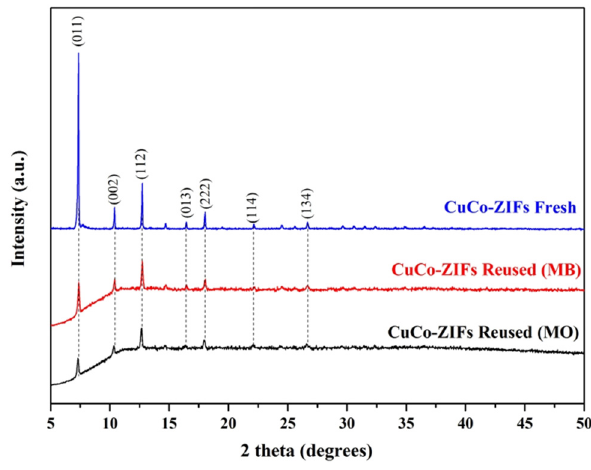
Figure 13: PXRD analysis of reused - CuCo - ZIFs, in comparison to fresh